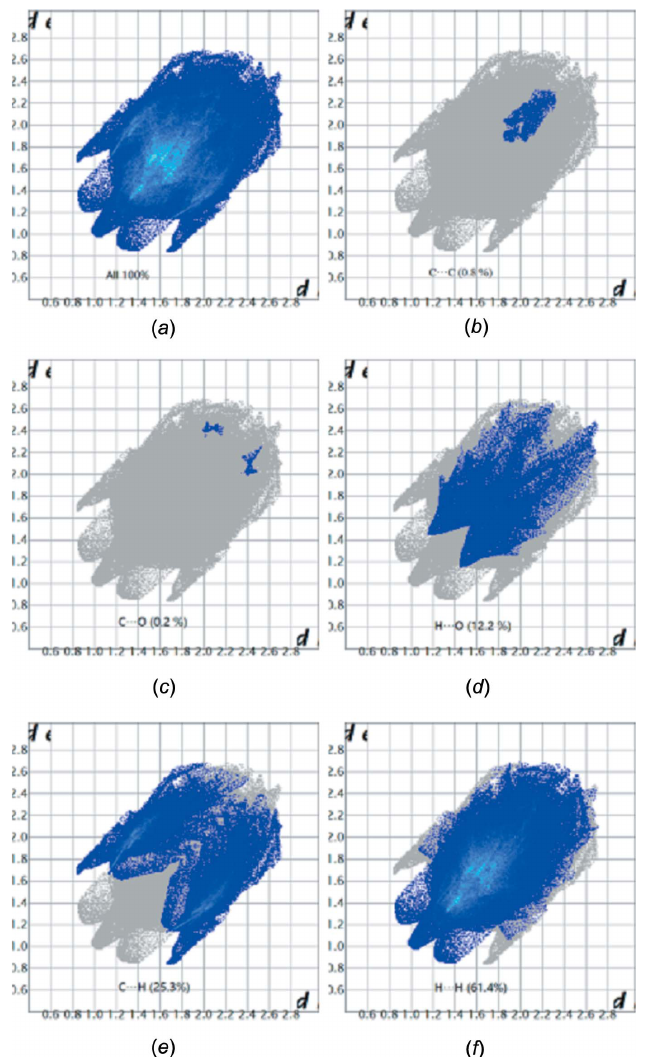
Figure 4 Two-dimensional fingerprint plots for the title compound: ( a ) all intermolecular interactions, ( b ) C (cid:2)(cid:2)(cid:2) C contacts, ( c ) C (cid:2)(cid:2)(cid:2) O/O (cid:2)(cid:2)(cid:2) C contacts, ( d ) H (cid:2)(cid:2)(cid:2) O/O (cid:2)(cid:2)(cid:2) H contacts, ( e ) C (cid:2)(cid:2)(cid:2) H/H (cid:2)(cid:2)(cid:2) C contacts and ( f ) H (cid:2)(cid:2)(cid:2) H